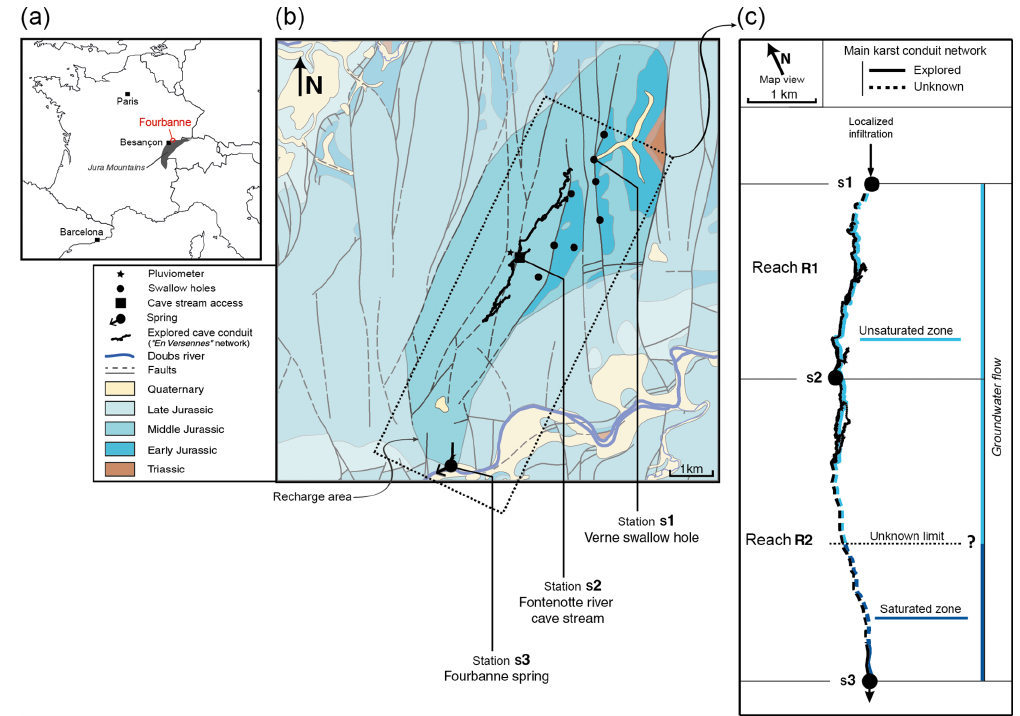
Figure 3. The Fourbanne karst system: (a) geographical localization, (b) hydrogeological map, (c) scheme of the main karst conduit network.